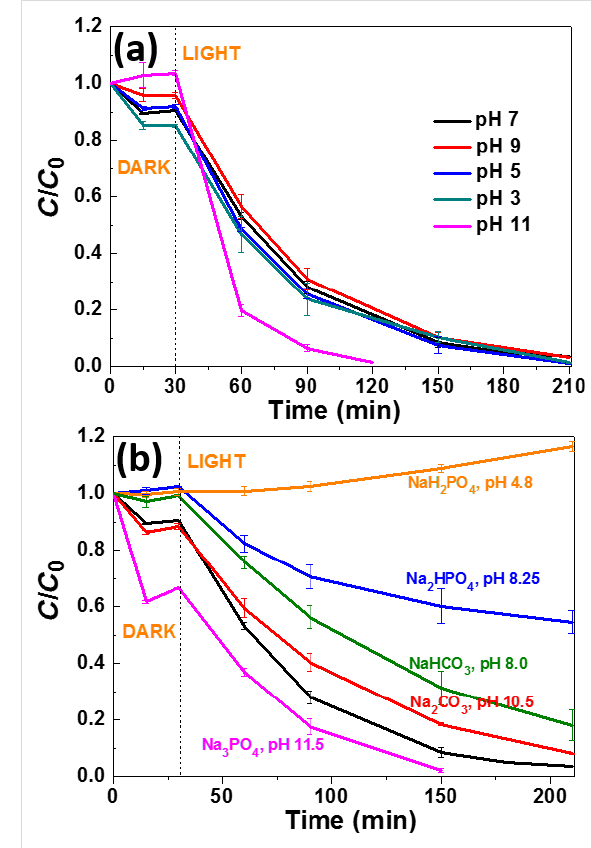
Figure 6: (a) Influence of pH and (b) of phosphates and carbonates on the photocatalytic activity of the ZnO/ZCIS composite (the black curve corresponds to the reference photocatalytic test conducted in water at pH